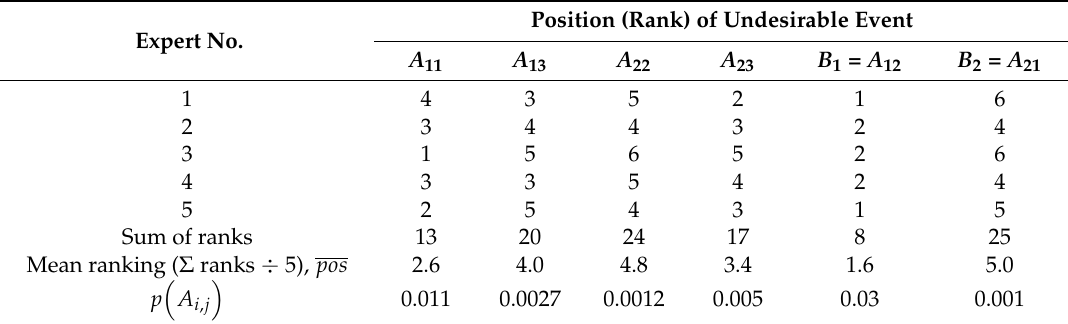
Table 3. Conjunctive table of undesirable basic event A ij and experts’ ranks.